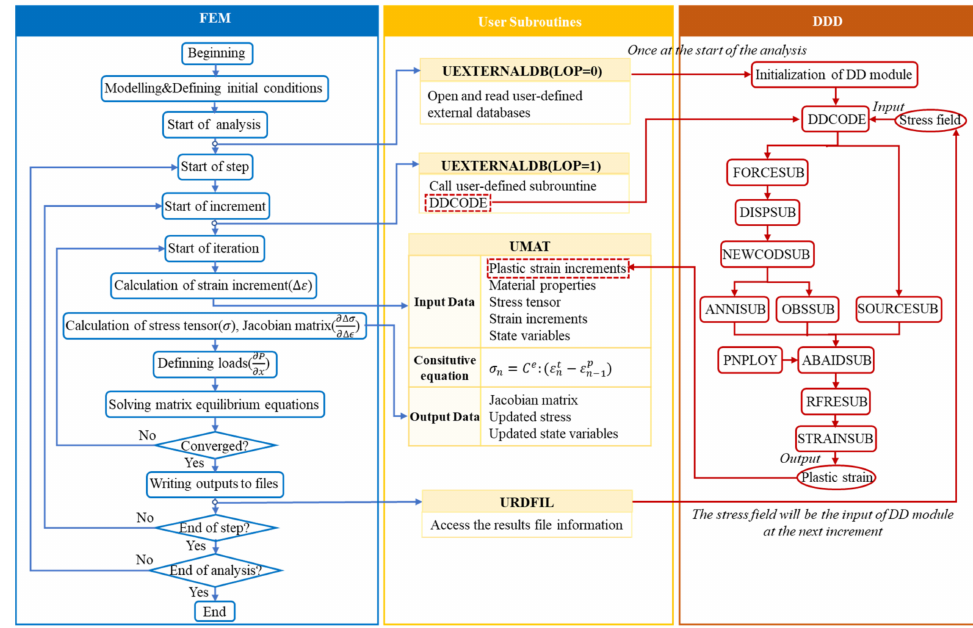
Figure 5. The workflow of the multiscale framework coupling FEM and